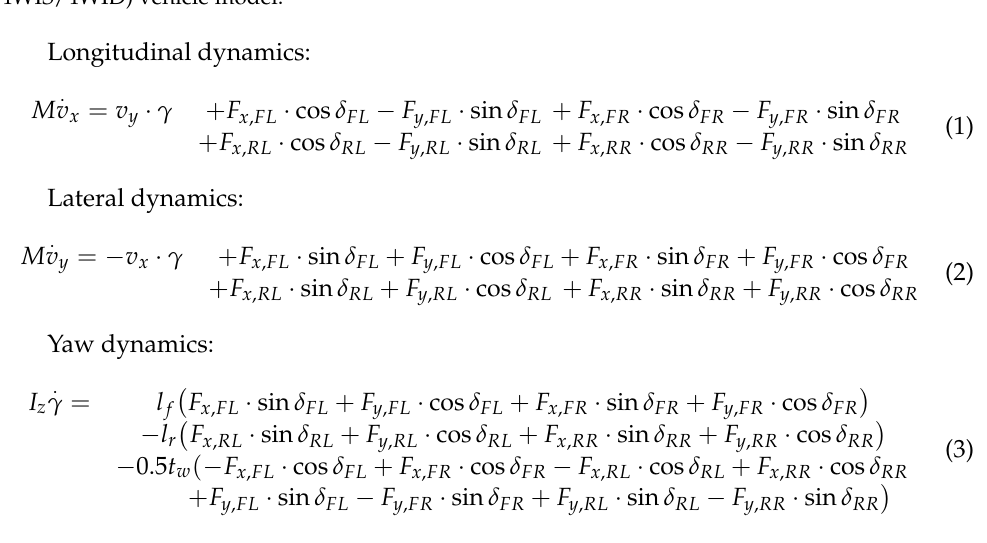
Figure 2. Free-body diagram of four-wheel independent steering/four-wheel independently driving (4WIS/4WID) vehicle